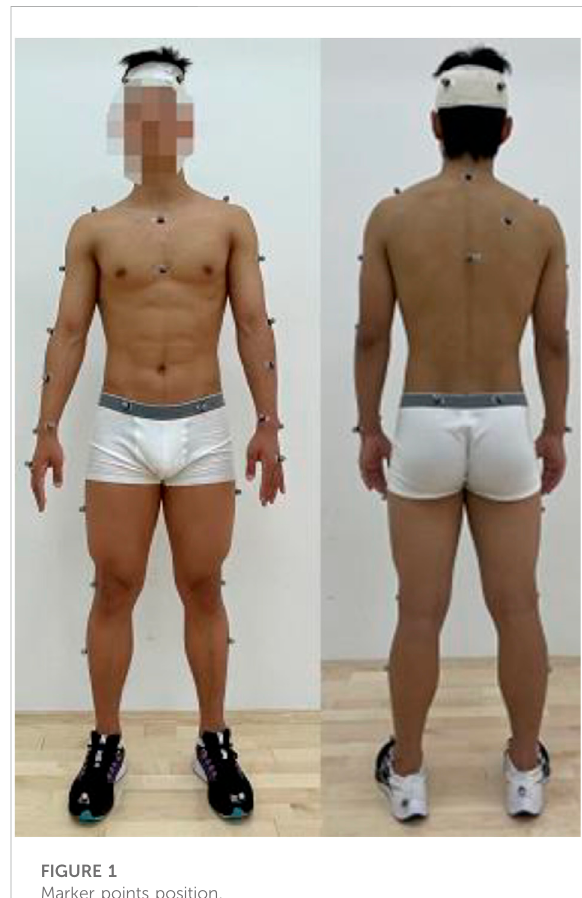
FIGURE 1 Marker points